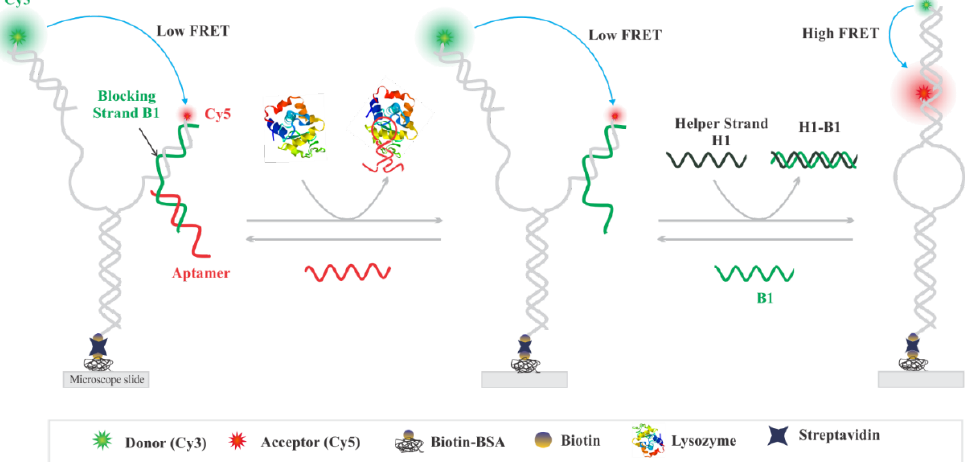
Figure 1. Sensor design and working principle. Sensor design with the fluorophore labeling scheme (Cy3: green and Cy5: red). The microscope slide was modified with biotinylated bovine serum albumin (BSA) and then with streptavidin to allow surface-immobilization of the biotinylated aptasensor via the biotin–streptavidin interaction. Lysozyme-specific aptamer prevents the helper strand (H1) from binding to the blocker strand (B1). When lysozyme takes the aptamer away from the sensor molecule, the toehold region of the B1 strand is exposed. This allows toehold-mediated displacement of B1, forming a B1–H1 duplex as a byproduct. This process allows the aptasensor molecules to adopt a closed conformation, leading to a significantly higher fluorescence resonance energy transfer (FRET) efficiency than that of the open conformation.